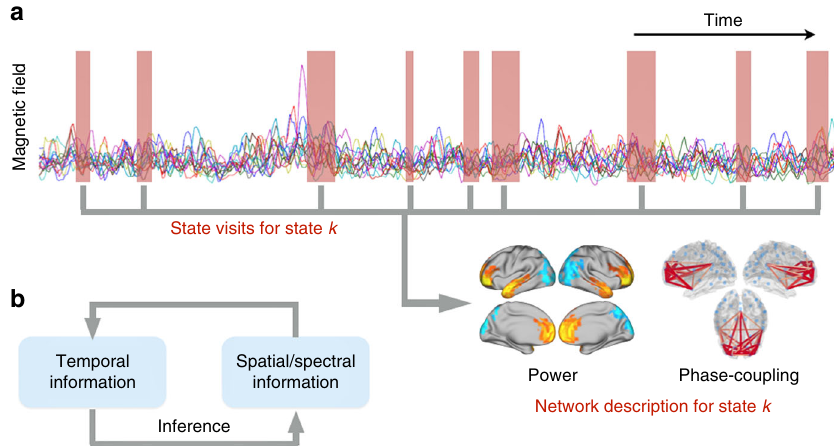
Fig. 1 Schematic illustration of the method. a Each state is de fi ned as having its own distinct temporal, spatial and spectral characteristics. The temporal information is given by when the state is active (red boxes). The spatial and spectral descriptions of the power maps and phase-coupling networks are contained in the parameters of each state. b Schematic of the iterative model inference. The state parameters are estimated using those segments of the data for which the state is currently estimated to be active. In turn, the estimation of when a state is active is based on the how well each state can explain each time point (i.e. according to the current estimate of the spatial/spectral state